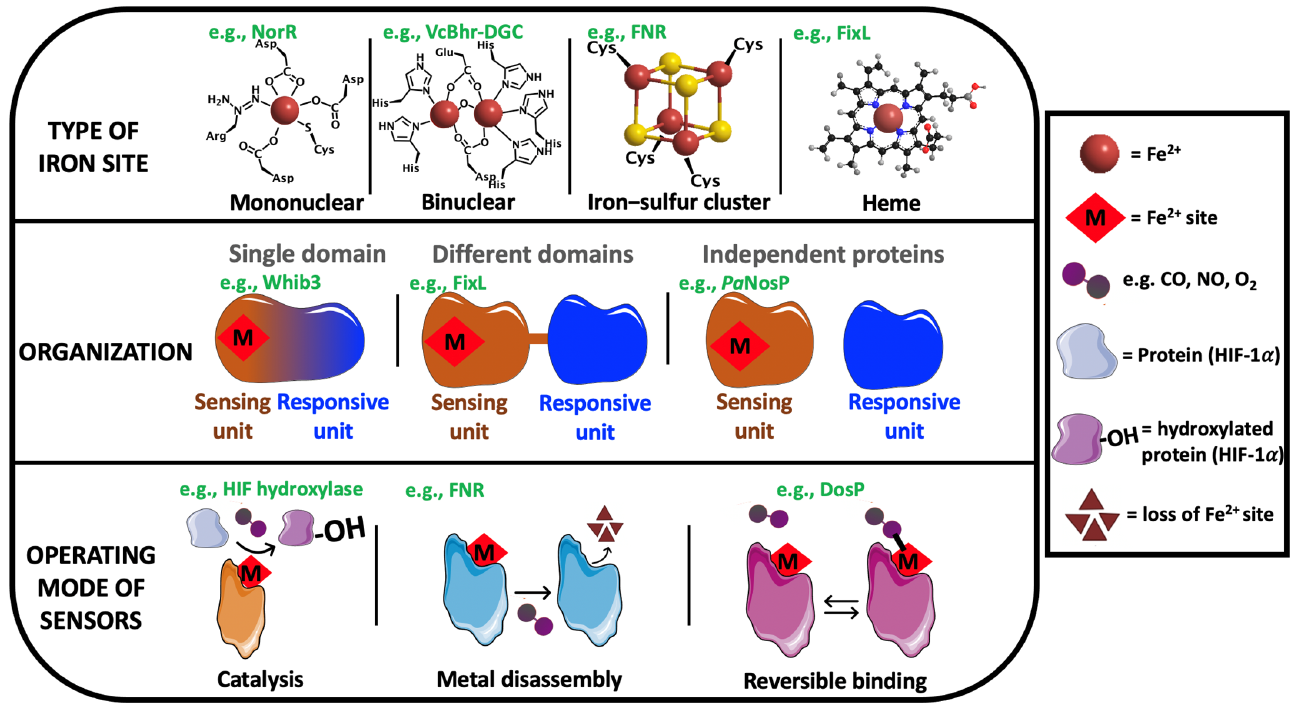
Figure 1. Basic building blocks of metal-based sensor proteins for O 2 , NO and CO and molecular functioning. Firstly, four types of iron sites are briefly illustrated with examples of gas sensors: mononuclear iron site of the NO sensor NorR from E. coli , binuclear iron site of the O 2 sensor Bhr-DGC from Vibrio cholerae , iron–sulfur cluster of the O 2 sensor FNR from E. coli , and heme iron site of the O 2 sensor FixL from Rhizobium . Then, it shows the overall organization of metal-based gas sensors with three distinct structural features along with examples such as Whib3 from Mycobacterium tuberculosis as a single protein sensor of NO/O 2 , FixL as a multi-domain O 2 sensor and Pa NosP from Pseudomonas aeruginosa with independent protein units functioning as an NO sensor and the responsive unit. The different general modes of operation of metal-based gas sensors are illustrated, where the first case involves catalysis using O 2 as shown by the O 2 sensor HIF hydroxylase. The next mode employs iron–sulfur cluster site disassembly represented by the O 2 sensor FNR, while the last case involves reversible binding to the gaseous signaling molecule as illustrated by the O 2 sensor DosP.